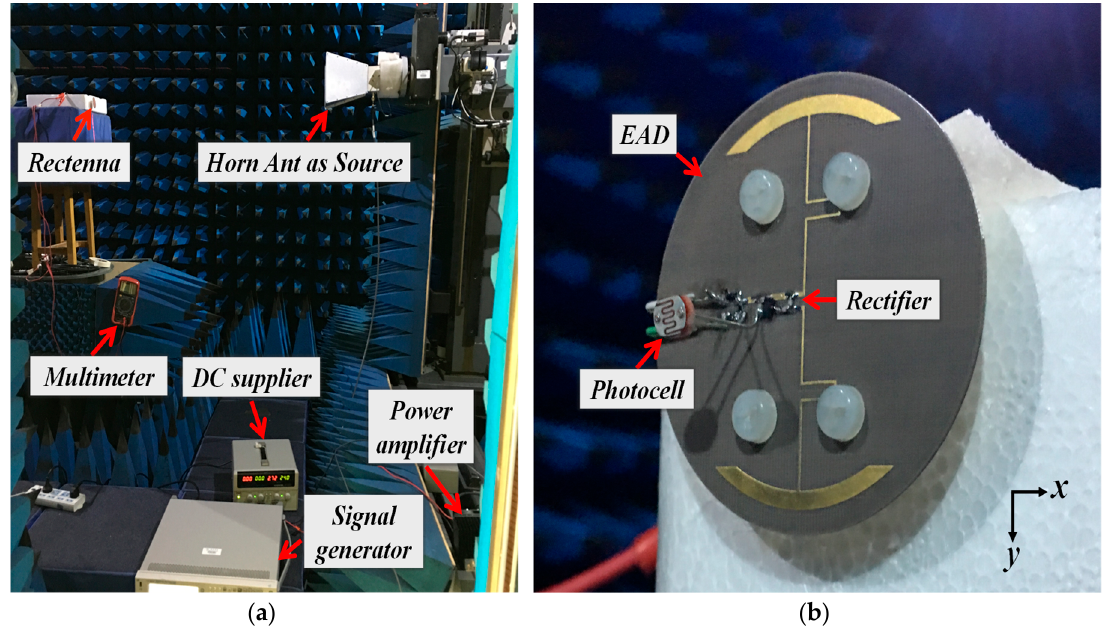
Figure 5. Sensor-augmented EAD rectenna: ( a ) experimental setup and ( b ) photocell-based prototype.